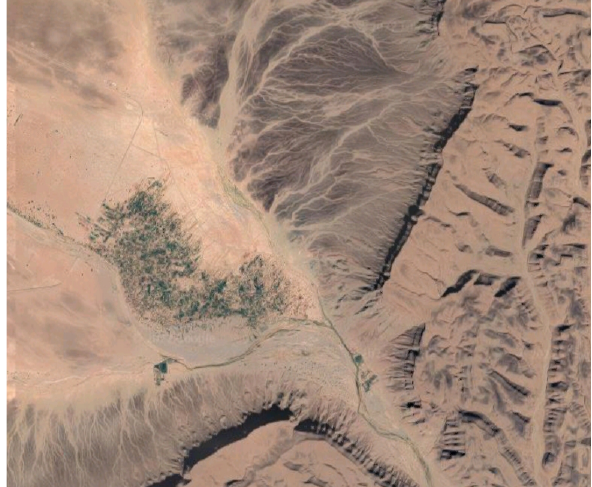
Figure 1 . Example of geography, climate and geology condition of an oasis alongside Oued Darâa in south-east Morocco (Source: